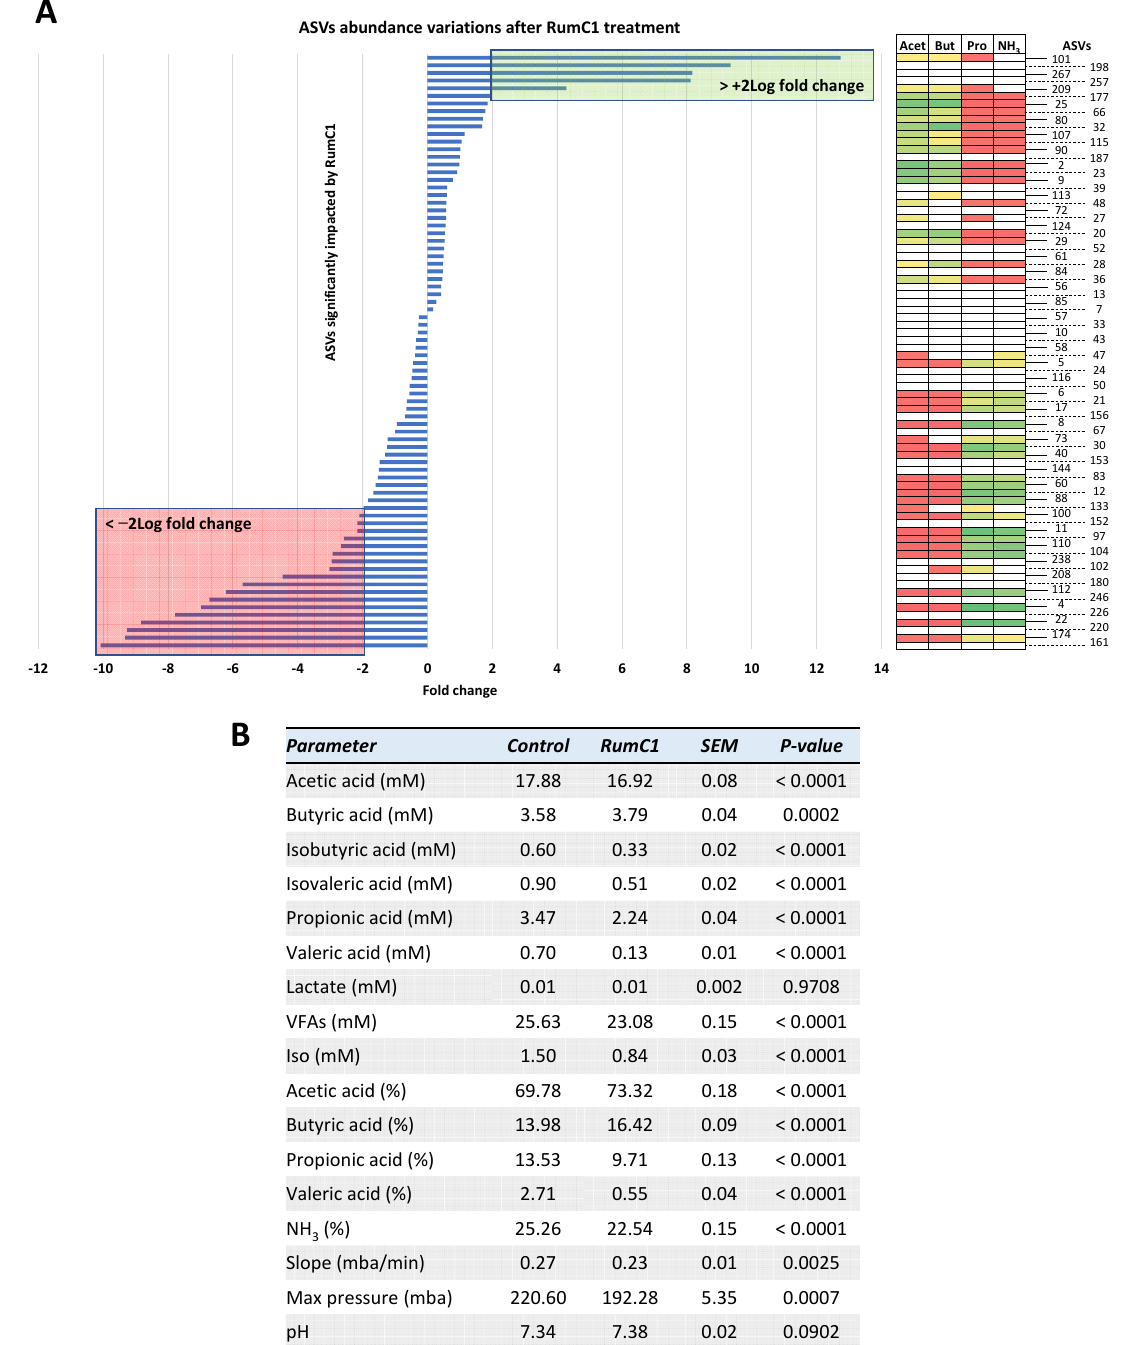
Figure 3. Main ASVs impacted by RumC1 treatment and their correlation with SCFA production. Cecal contents of broiler chickens were supplemented with C. perfringens CP24 at 10 6 CFU/mL and treated with RumC1 at 5 × MIC of C. perfringens CP24 or left untreated (control). ( A ) The ASVs significantly (i.e., Pearson > 0.8 and p -value < 0.05) impacted by RumC1 are shown on the figure as well as their correlation with metabolite production using a color gradient from red (poor producer) to green (good producer), respectively. ( B ) SCFA production and fermentation parameters for each group were statistically analyzed by ANOVA test. SEM = standard error of the mean. Slope, maximum pressure, and pH were the parameters measured during the fermentation. Slope = rate of gas production in the exponential phase, max pressure = maximum gas production in 24 h, pH = final pH after 24 h of